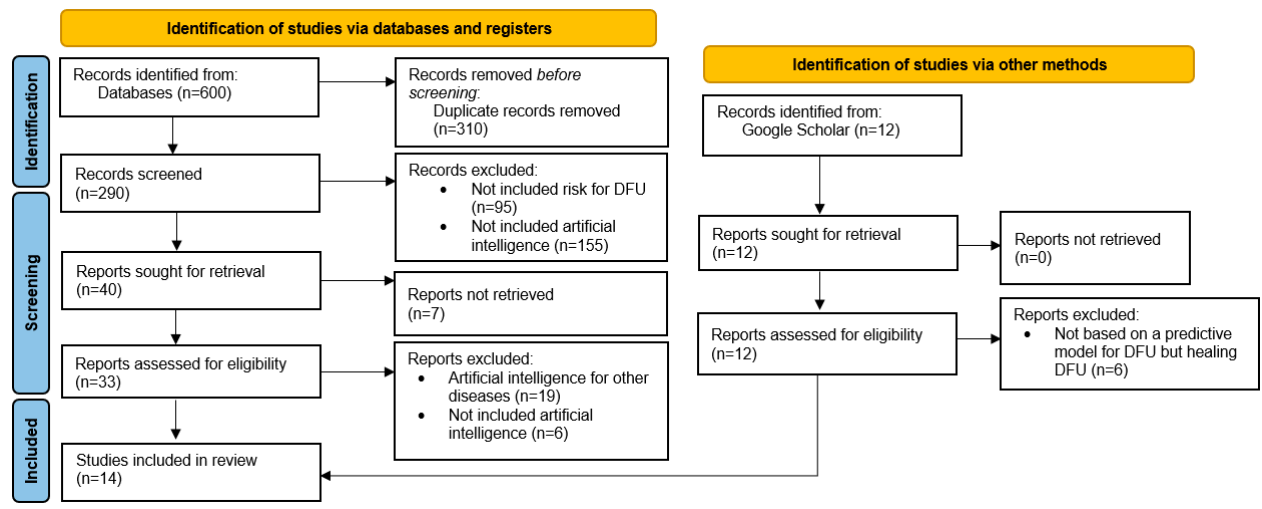
Figure 1. PRISMA flow diagram.